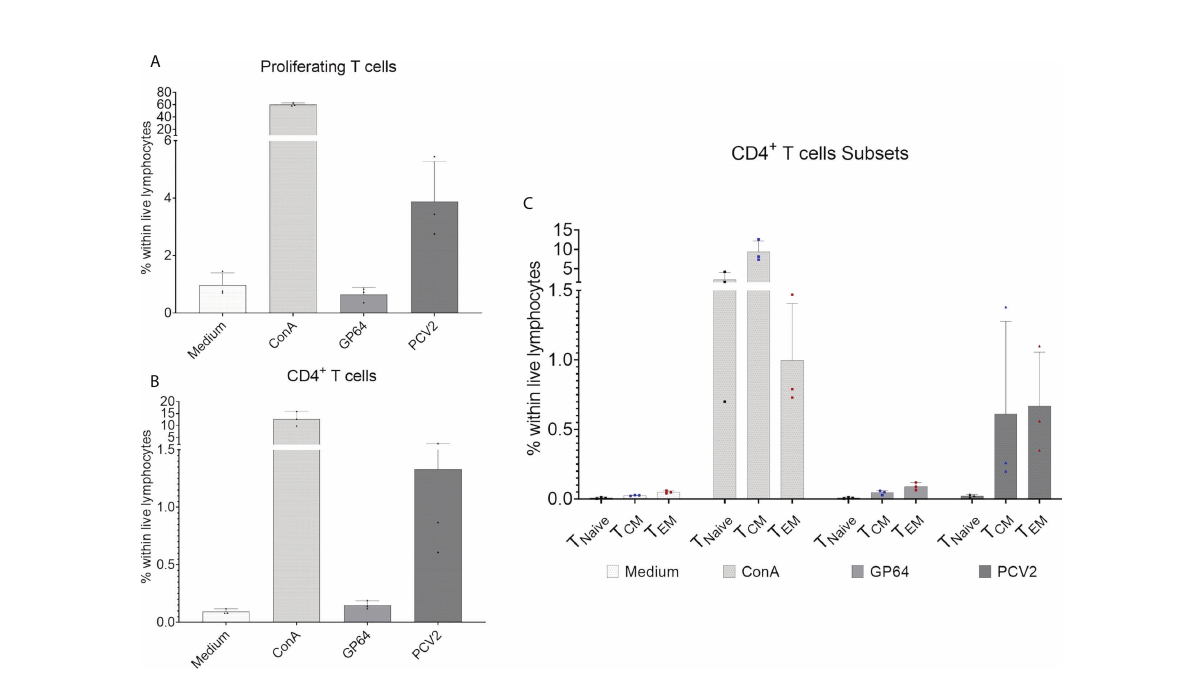
FIGURE 8 Proliferation assay of CellTrace ™ Violet-stained PBMCs after restimulation with baculovirus-expressed PCV2-ORF2 protein. PBMCs cultivated in medium or stimulated with an irrelevant baculovirus-expressed protein (GP64) were used as negative controls, ConA-stimulated PBMCs served as positive control. (A) Shows the percentage of reacting T cells within live lymphocytes of three representative EGMs. (B) shows the percentage of proliferating CD4 + T cells within live lymphocytes of three EGMs. (C) Shows the reactivity of the CD8 a /CD27-de fi ned CD4 + T- cell subpopulation of three EGMs. Naive CD4 + T cells (T Naive ), central memory CD4 + T cells (T CM ) and effector memory CD4 + T cells (T EM